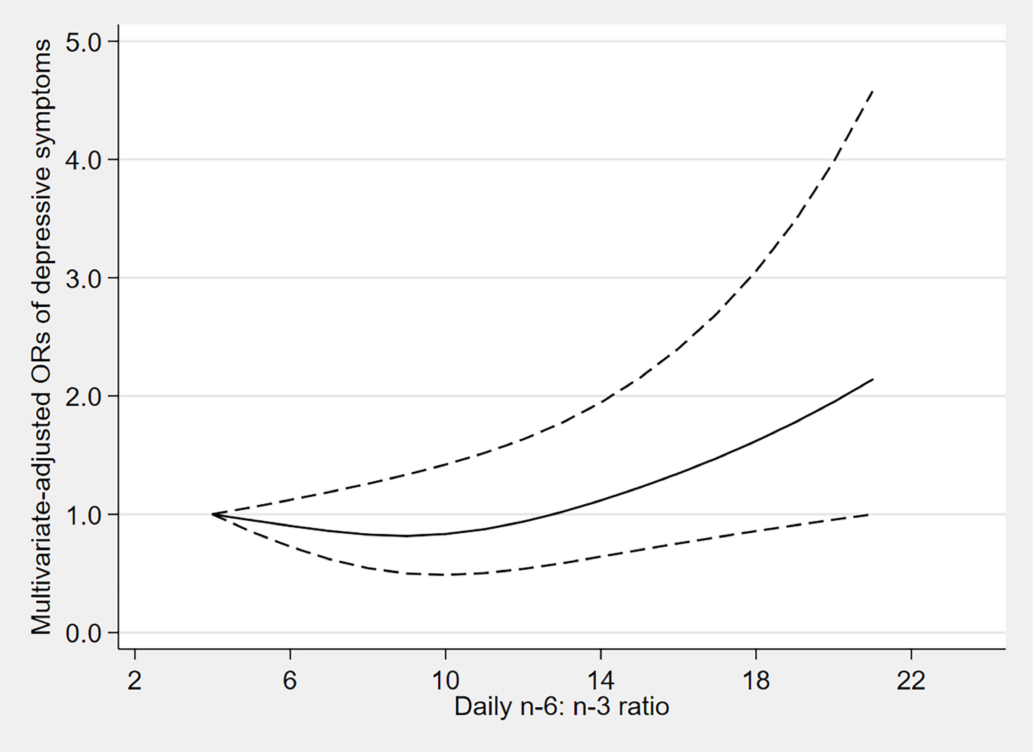
Figure 4. Dose–response relationship between n-6:n-3 ratio and the risk of depressive symptoms. The solid line represents the OR values and dashed lines represent the 95% confidence